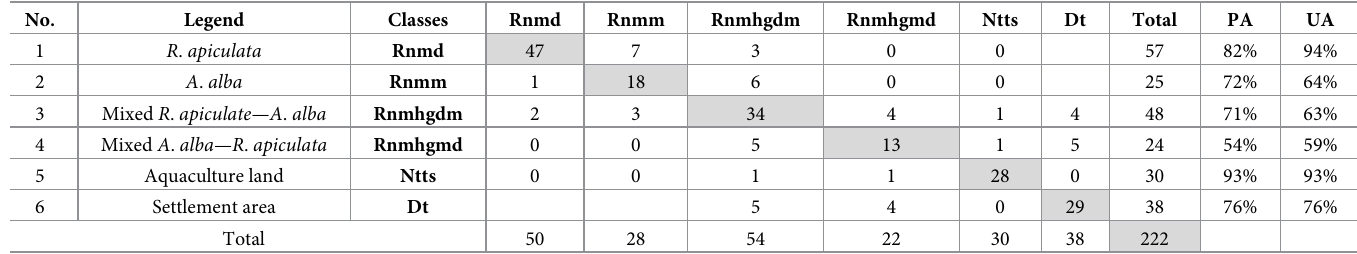
Table 3. The confusion matrices of classified